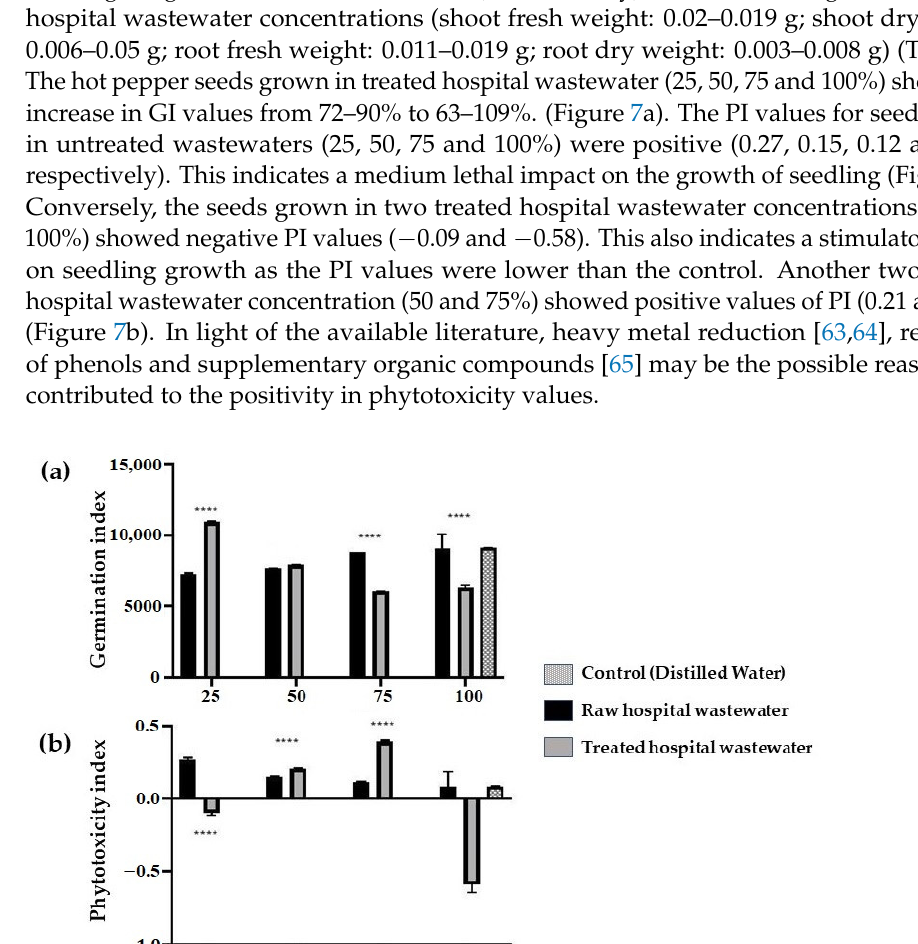
11 of 19 Figure 6. ( a ) Germination indices of Cauliflower seeds grown in untreated and treated hospital wastewaters; ( b ) Phytotoxicity indices of Cauliflower seeds grown in untreated and treated hospital wastewaters. Significance (Welch’s test) between treated and untreated hospital wastewater is indi-